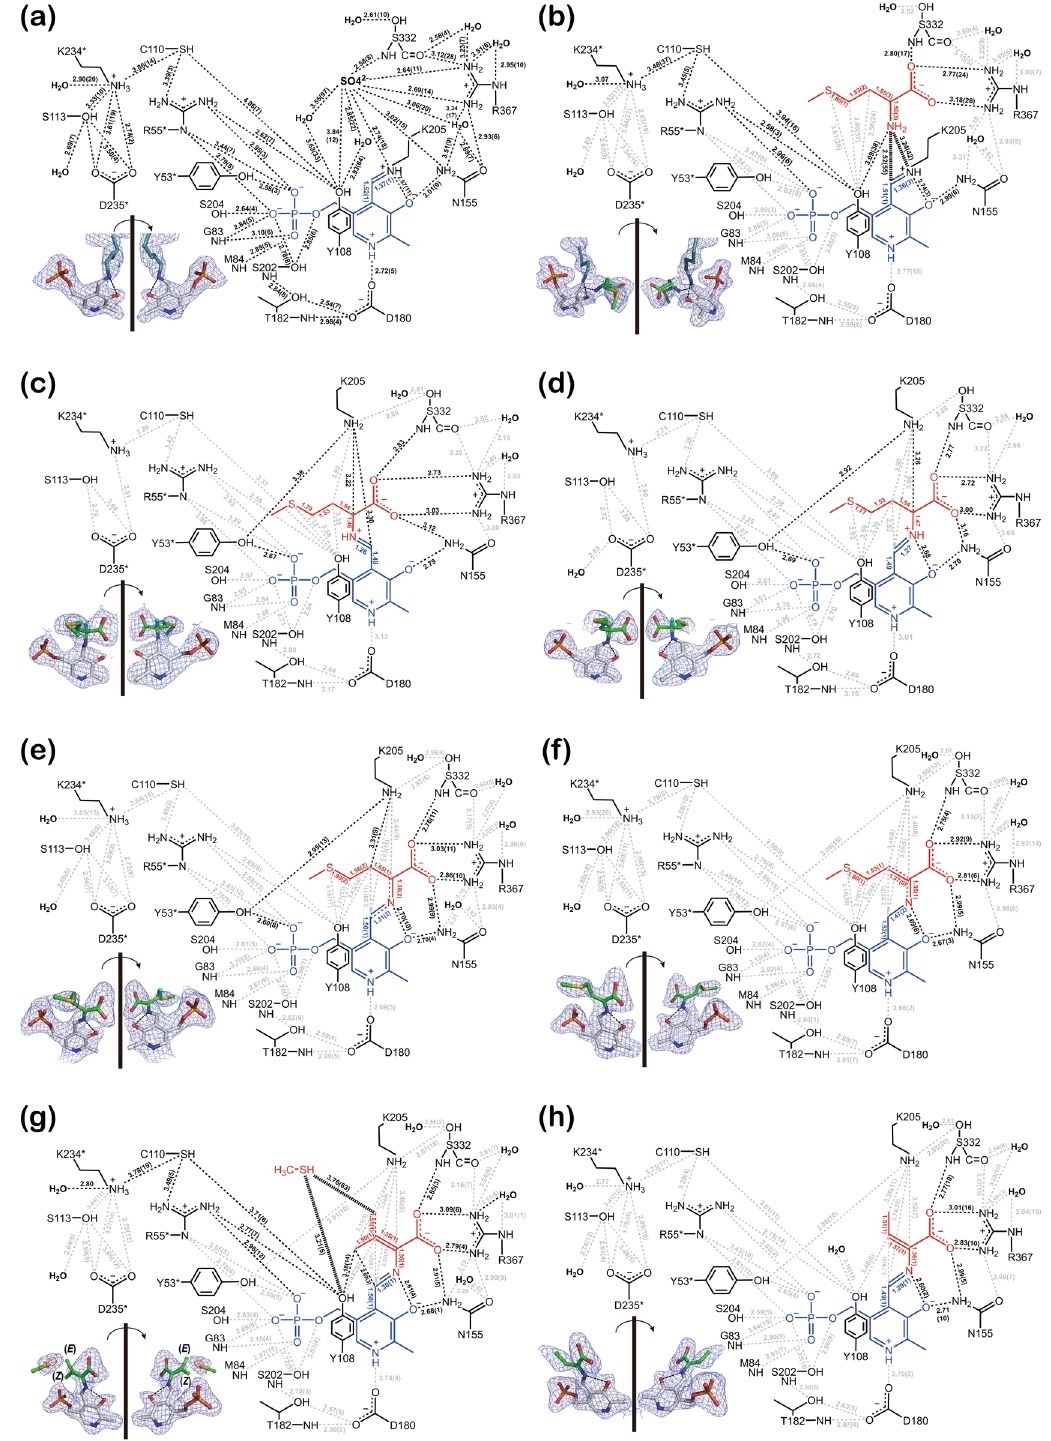
Figure 2. Schematic drawings of the active sites with interatomic distances. ( a ) substrate-free form, ( b ) Michaelis complex, ( c ) intermediate 1a , ( d ) intermediate 1b , ( e ) intermediate 2 , ( f ) intermediate 3 , ( g ) intermediate 4a and an eliminated methanethiol, and ( h ) intermediate 4b . PLP and substrate moieties of the bound Schiff base are colored in blue and red, respectively. Double configurations about the C β –C γ bond observed in intermediate 4a are indicated as red solid ( Z isomer) and dashed ( E isomer) lines. All interactions in ( a ) and the important interactions in catalysis in ( b – h ) are indicated as black dotted lines. For intermediates with multiple determined structures, average interatomic distances (Å) are shown with their standard deviations in parentheses. The structure of each intermediate is shown in inset. The H α atoms of intermediate 1a and 1b and the H β atom of intermediate 2 are shown as cyan-colored stick at their calculated positions. Electron densities contoured at 1.0 σ and 2.0 σ levels are shown as blue and purple cages, respectively. Dashed line indicates a hydrogen